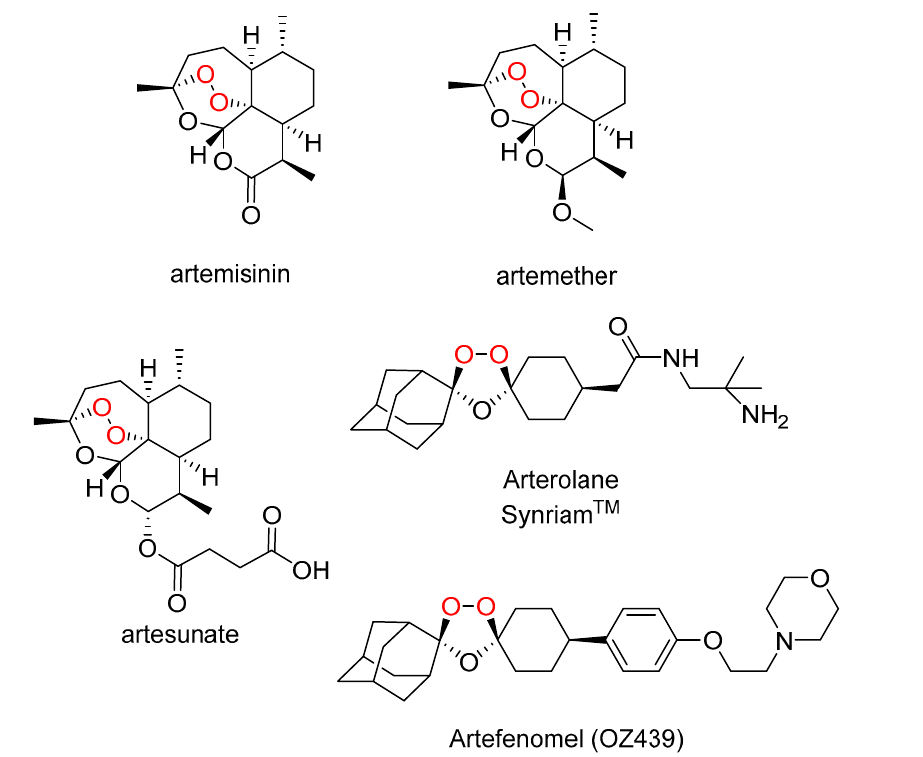
Figure 1. Artemisinin, its semi-synthetic derivatives, and synthetic Arterolane.